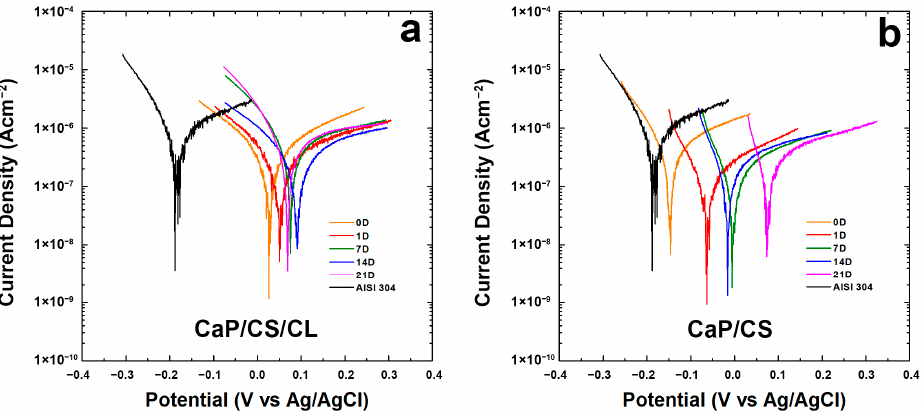
Figure 6. Tafel plots of the coating during 3-weeks of aging in the SBF solution: ( a ) CaP/CS/CL and ( b ) CaP/CS. Tafel curves were recorded immediately after immersion (0 D), after 1 (1 D), 7 (7 D), 14 (14 D), and 21 (21 D) days of immersion in SBF. The Tafel curve of the bare steel was also reported for comparison. Table 2. E corr and i corr of CaP/CS/CL and CaP/CS coatings obtained by extrapolation of Tafel’s curves from Figure 6. For comparison, E corr and i corr of the uncoated substrate were also reported. The mean standard deviation was ± 2%.